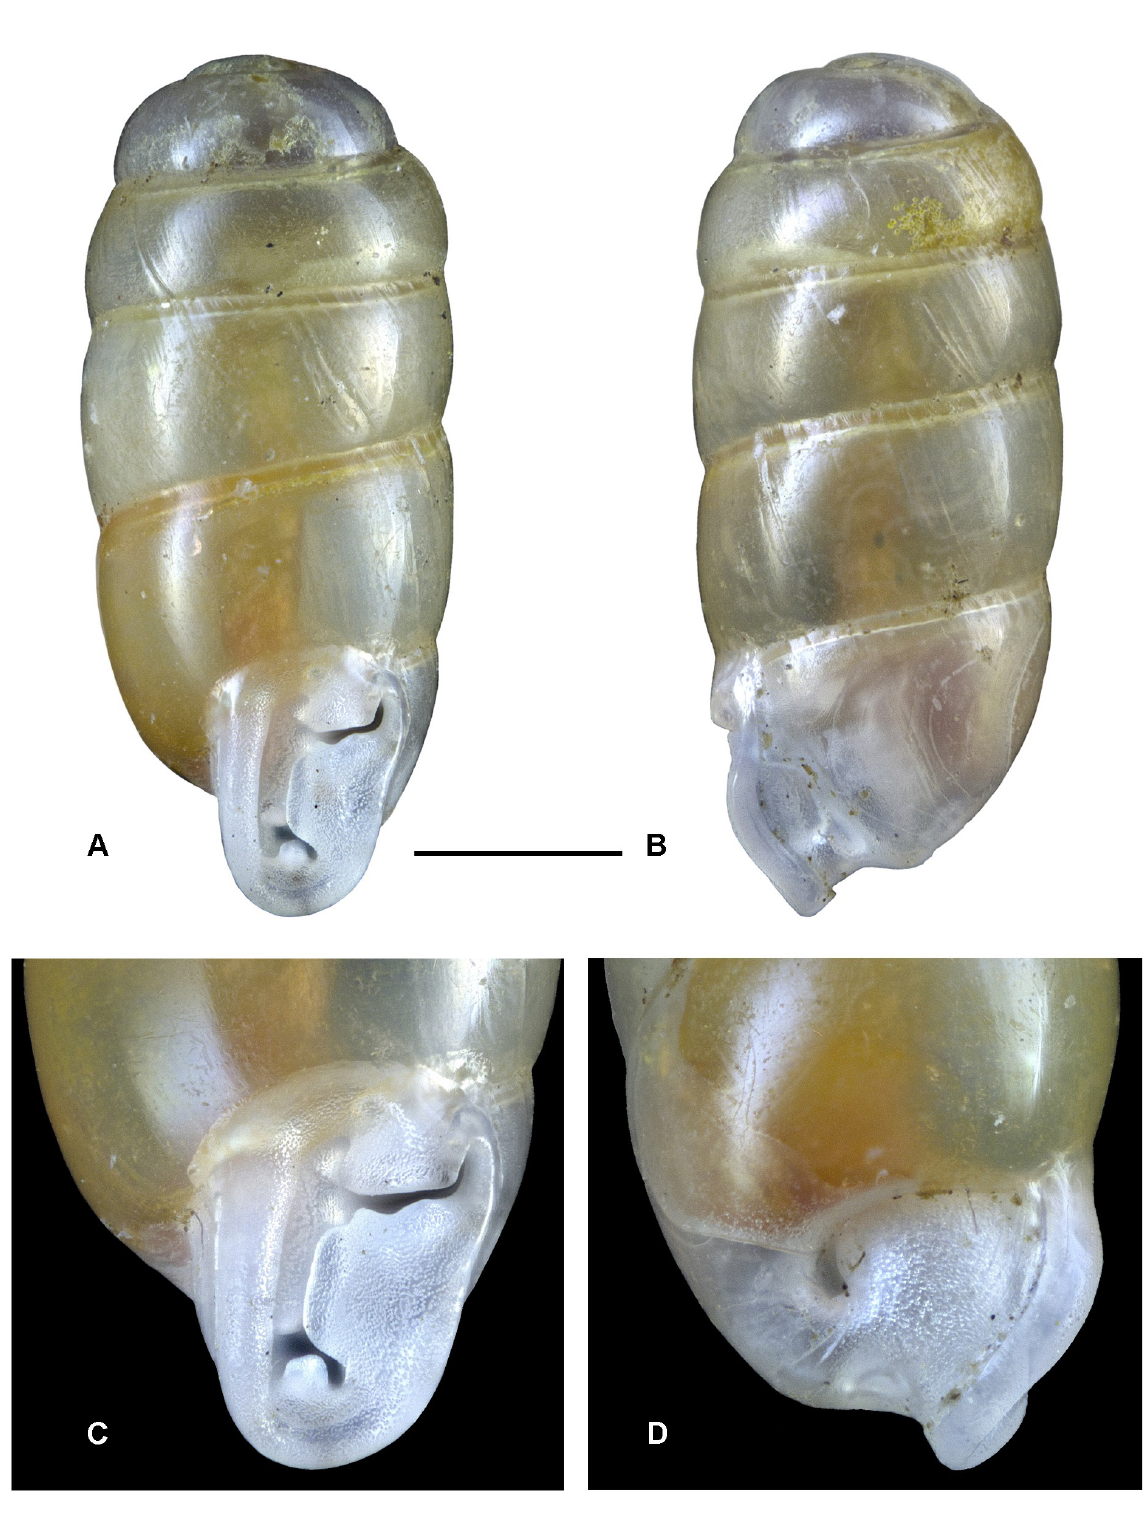
Fig. 8. Gulella calcicola sp. nov., holotype (NMSA P1675/T4519), length 2.05 mm, width 0.90 mm. A . Aperture view. B . Side view. C . View into aperture. D . Oblique view of base showing umbilicus. Scale bar = 0.5